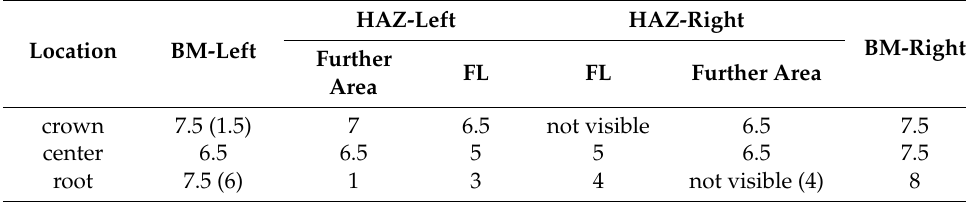
Table 5. Grain size G in the A sample, aged at 650 ◦ C for 7560 h.